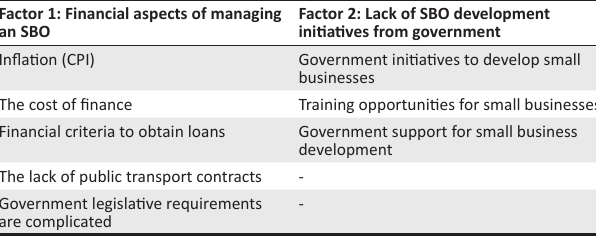
Factor 2: Lack of SBO development initiatives from